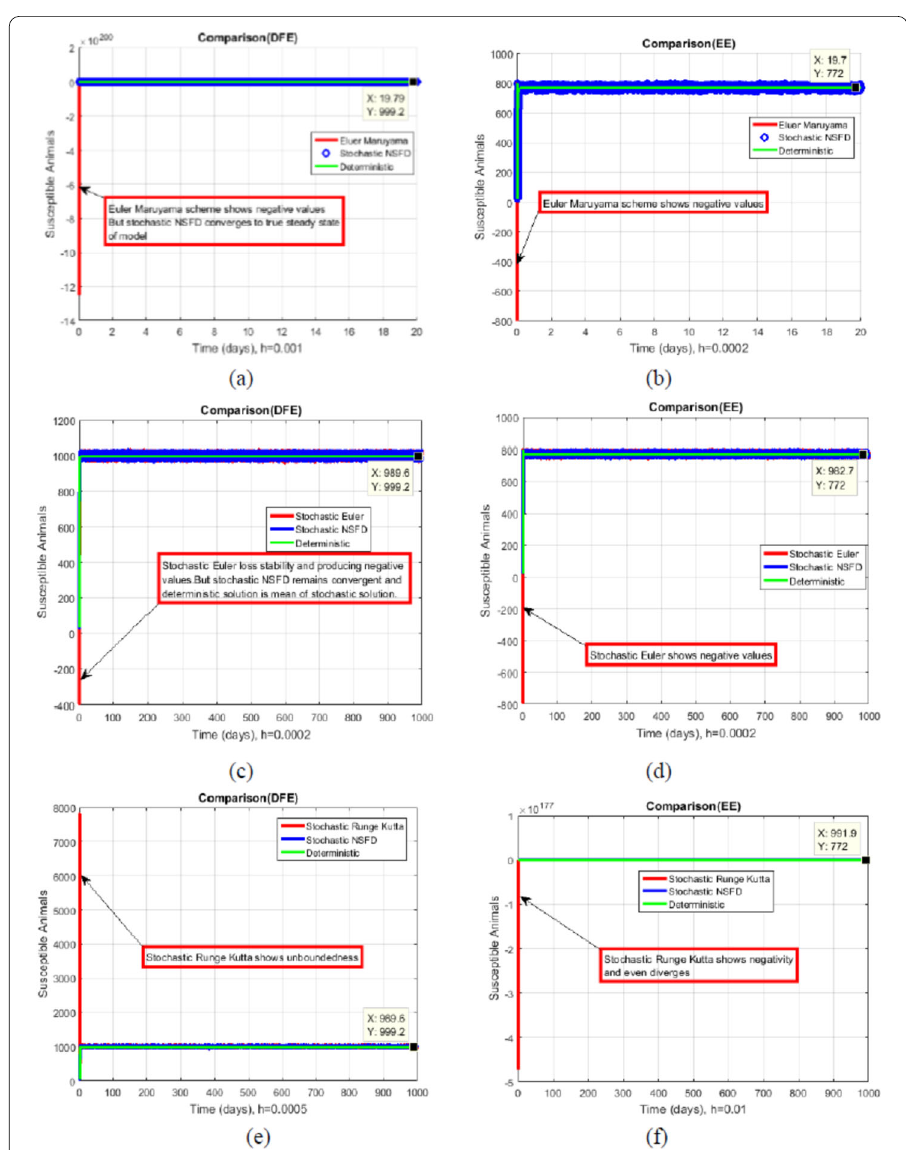
Figure 7 Comparison in solutions of explicit methods, stochastic NSFD and deterministic